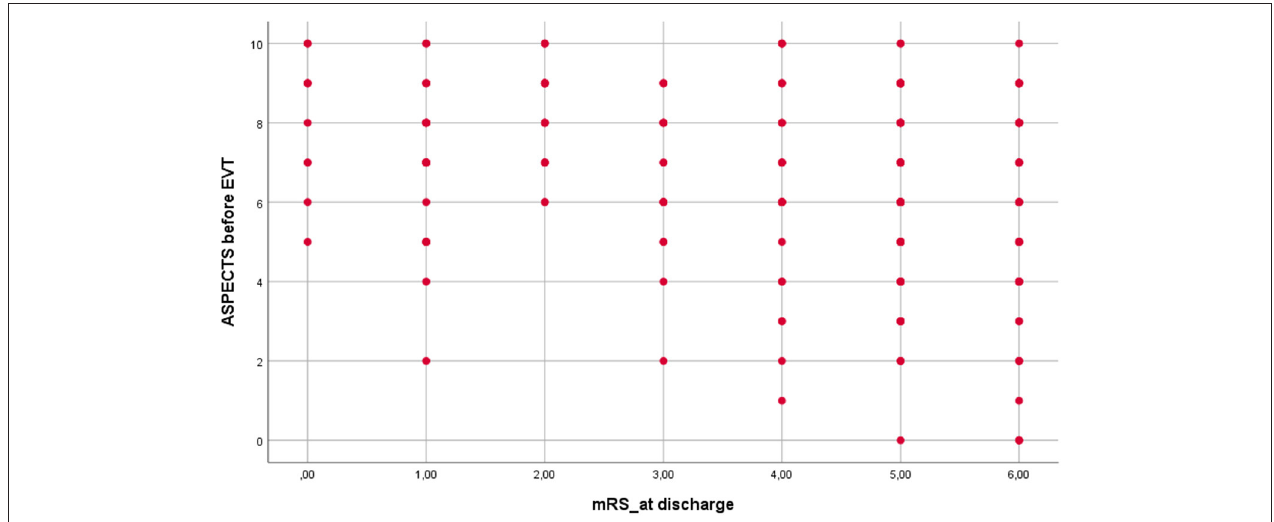
FIGURE 4 | Modified Rankin Scale (mRS) at discharge in relation to Alberta Stroke Program Early CT Score (ASPECTS) on admission (Spearman rho correlation: r = − 0.295; p < 0.001).